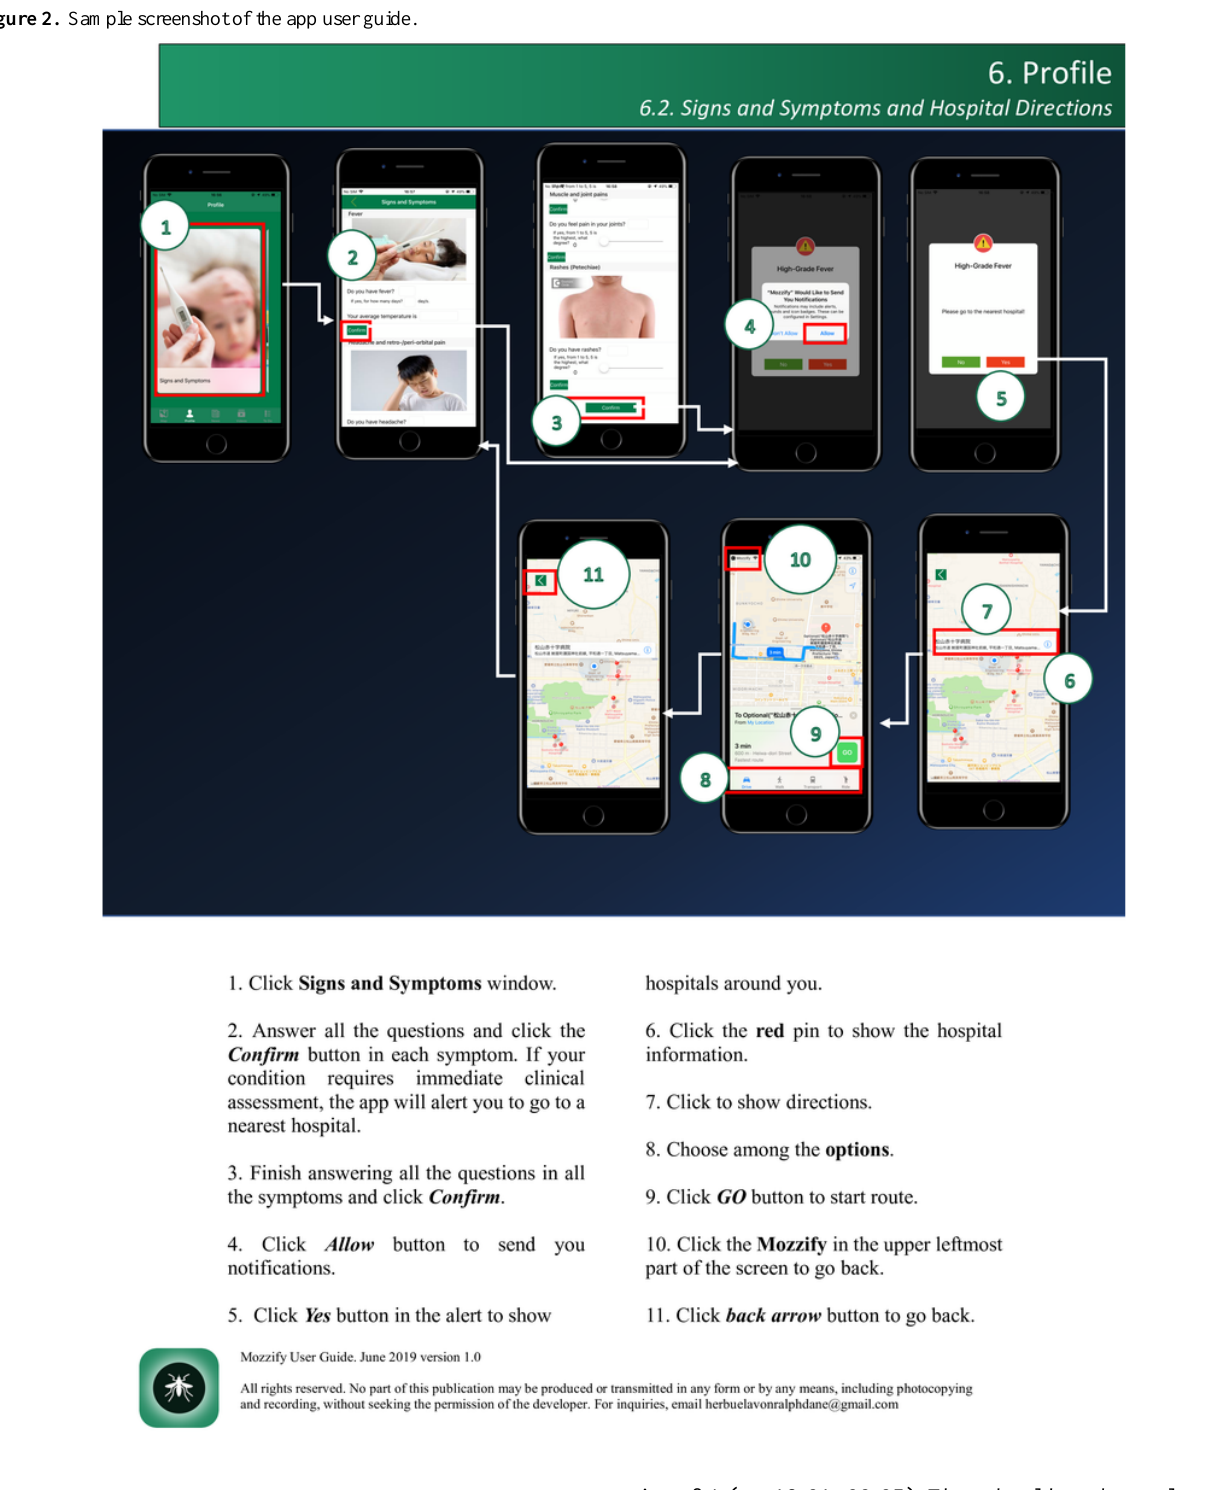
Figure 2. Sample screenshot of the app user